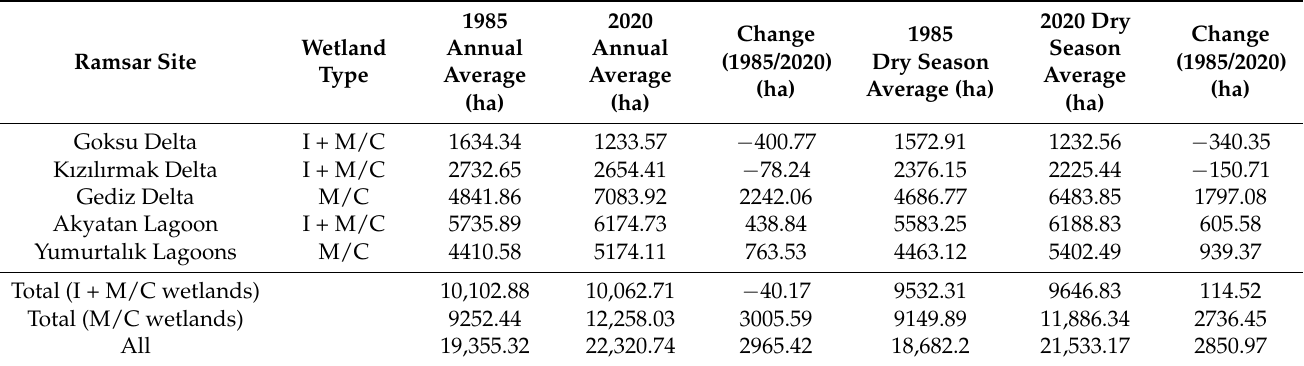
Table 3. Water Surface Areas (Annual and Dry Season Averages) at Turkey’s Coastal Ramsar Sites in 1985 and 2020 and Changes